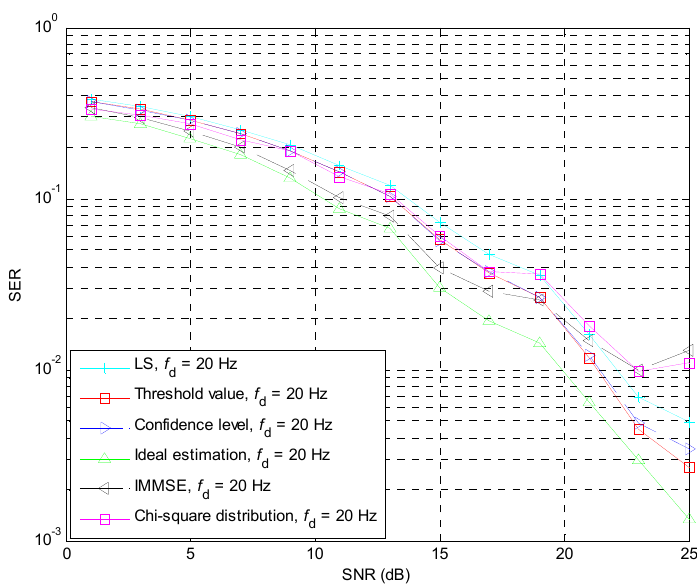
Figure 8. SER performance of the 16 QAM-modulated CP-OFDM system over Brazil A under T 1 = 5.